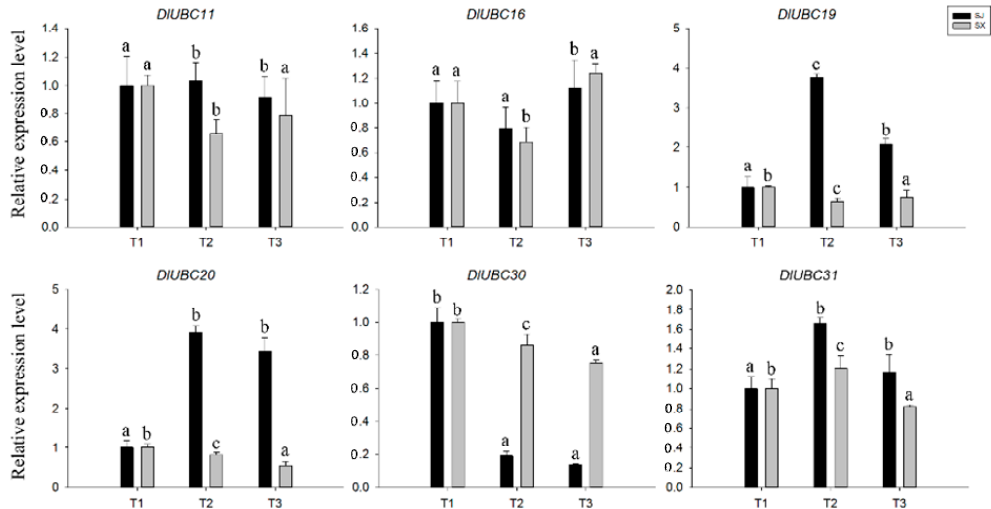
Figure 5. Relative expression levels of six DlUBCs during the three flowering stages of the two longan species by qRT-PCR. For each gene, the relative expression level in T1 (dormant apical bud) was set as one, and the longan actin gene was used as the internal expression control. The data represents the mean ± SD of three replicates. Values with the same letter were not significantly different when assessed using Duncan’s multiple range test ( p < 0.05, n = 3).